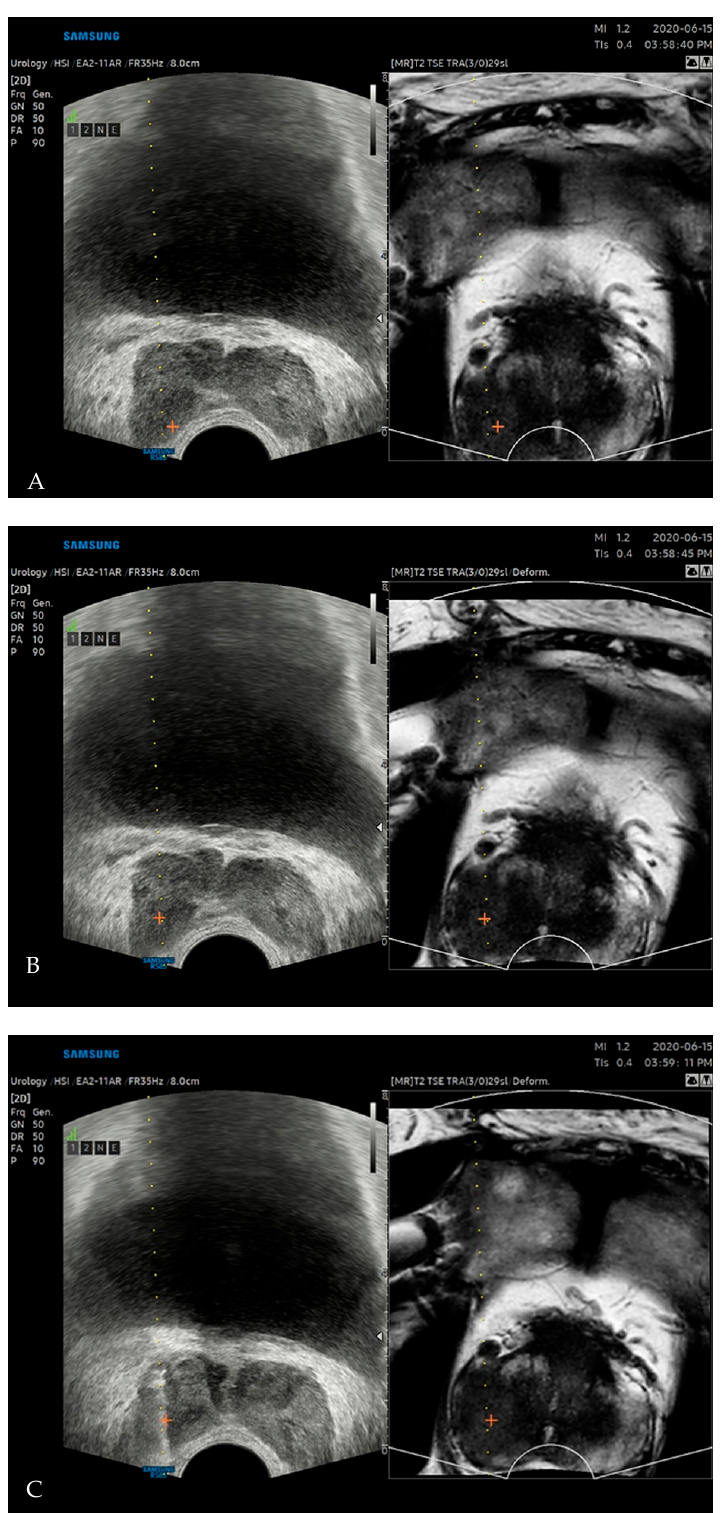
Figure 2. Fusion prostate biopsy of a 64-year-old male. Rigid registration between US and MRI ( A ) was performed, and index lesion was marked as cross on MRI, and transferred to the US. After nonrigid registration, deformed MRI and repositioning of index lesion markers in US were noted ( B ). Adenocarcinoma with a Gleason score of 8 (4 + 4) was confirmed by targeted biopsy performed on the index lesion ( C ). Trans-registration error decreased from 4.78 to 0.46 mm by switching from rigid to nonrigid